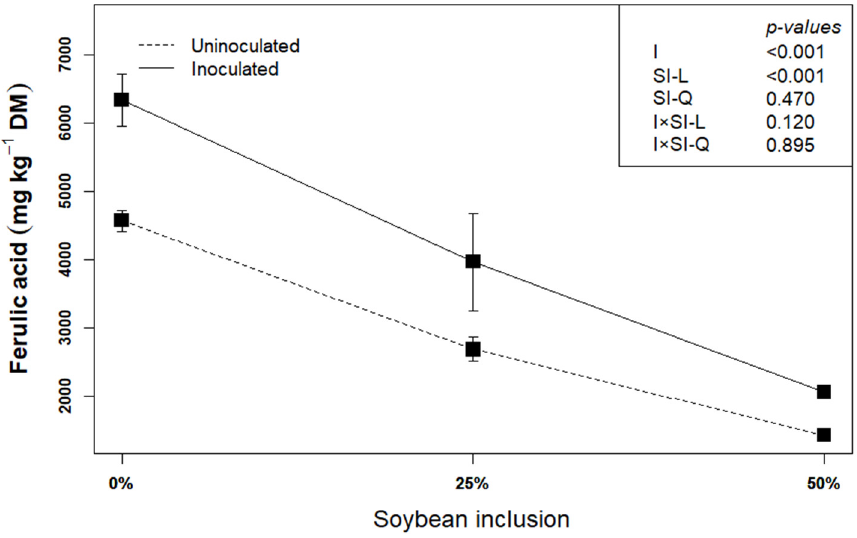
Figure 2. Influence of soybean inclusion and L. plantarum A1 inoculation on the concentration ferulic acid of sorghum silage.